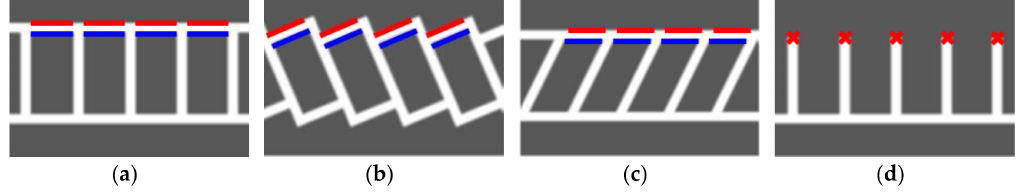
Figure 8. Entrances of four types of parking slot markings. ( a ) Rectangular type; ( b ) Slanted rectangular type; ( c ) Diamond type; ( d ) Open rectangular type.